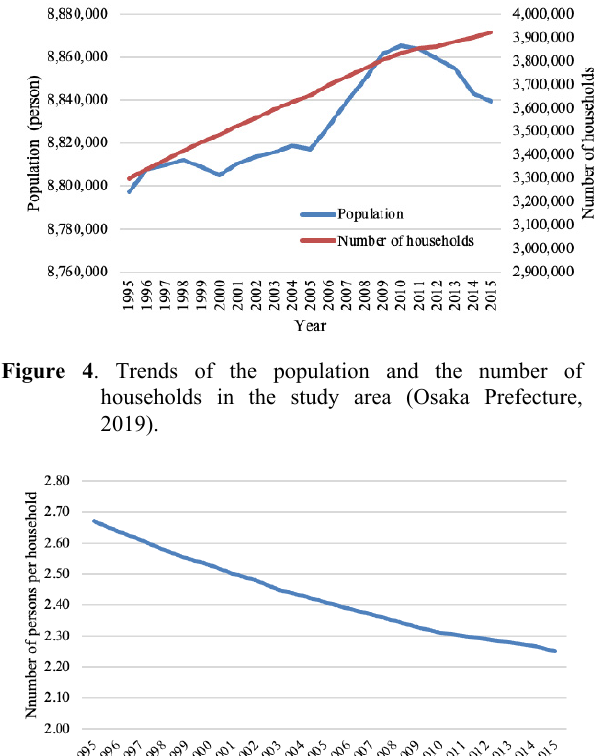
Figure 3 . Relative frequency distributions of local population density within ASP (Kumagai et al. 2021).